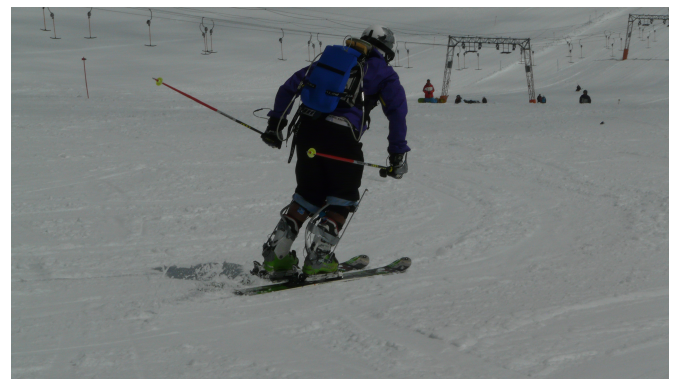
Figure 1. A skier equipped with the entire measurement setup consisting of GNSS and IMU